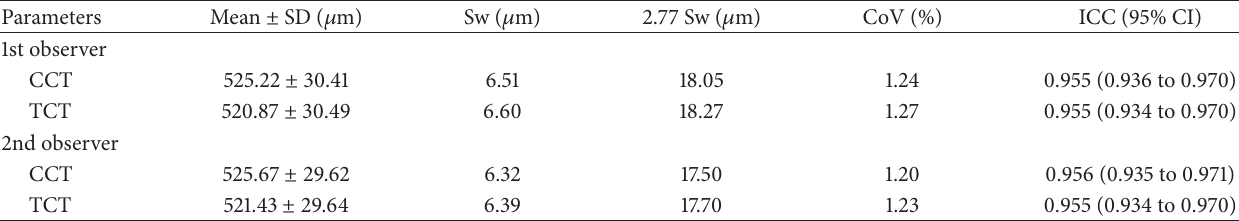
Table 1: Intraoperator repeatability of central corneal thickness (CCT) and the thinnest corneal thickness (TCT) readings using the Scheimpflug-Placido topographic modeling system (TMS-5).